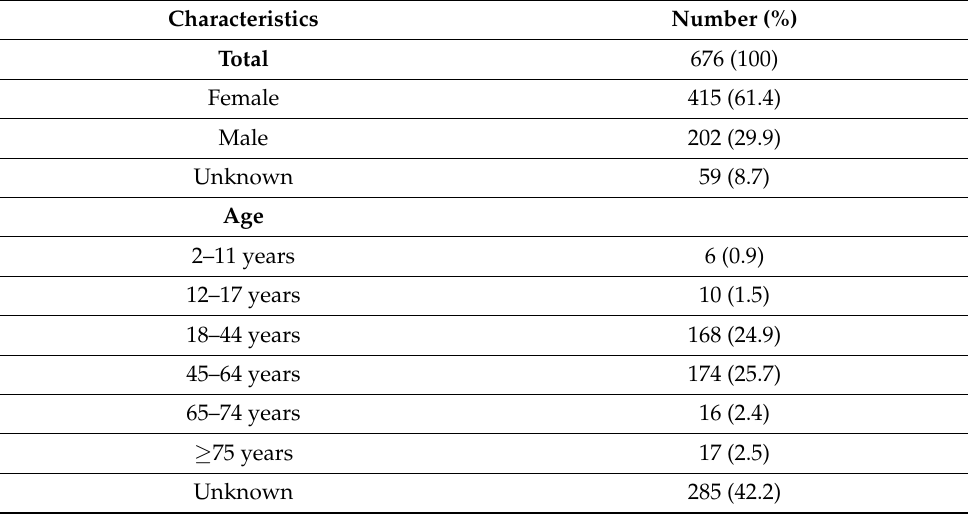
Table 1. Characteristics of the reports of patients with sleep-related eating disorder